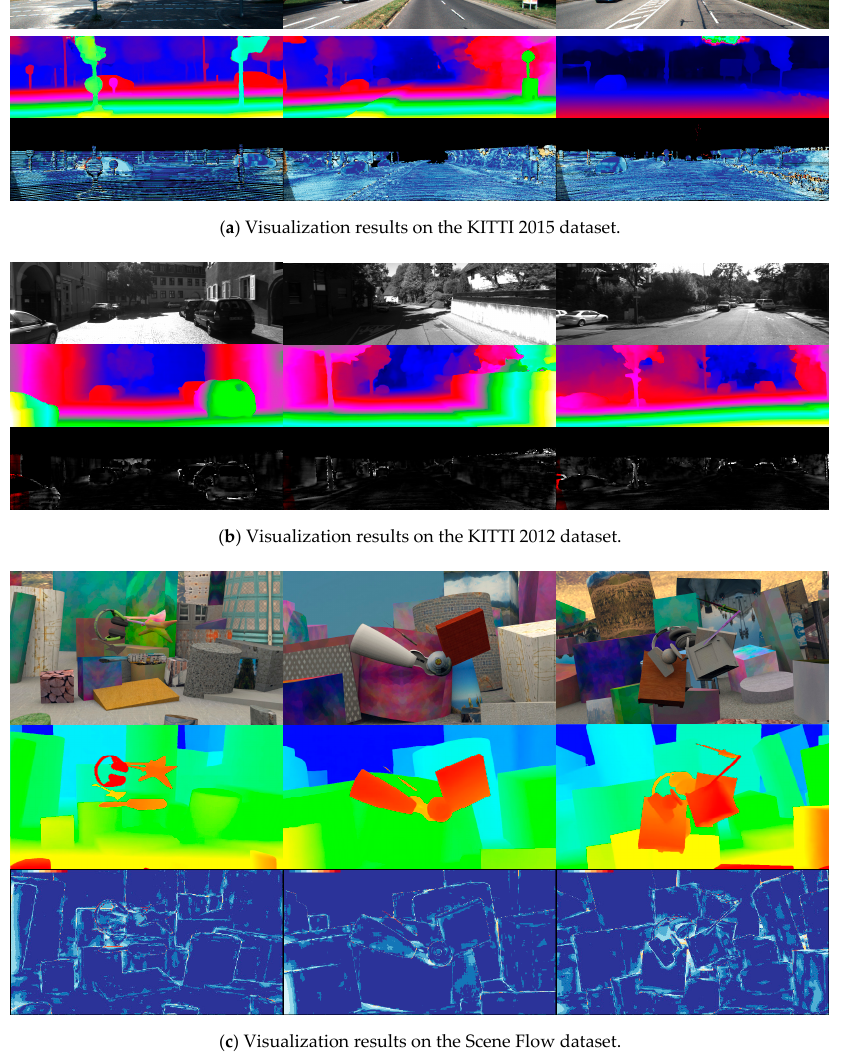
Figure 6. Depth visualization results on the test sets of di ff erent datasets. From top to down, left images, generated disparity maps, and error maps.